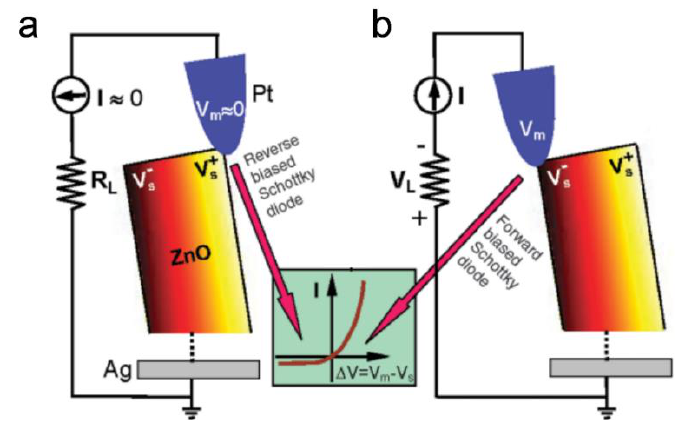
Figure 3. Working principle of a piezoelectric nanogenerator (PENG): contacts between the atomic force microscope (AFM) tip and the semiconductor ZnO nanowire at two reversed local contact potentials (positive and negative), showing reverse and forward biased Schottky rectifying behavior, respectively. This oppositely biased Schottky barrier across the nanowire preserves the piezoelectric charges and later produces the discharge output. The inset shows a typical current–voltage (I–V) relation characteristic of a metal-semiconductor (n-type) Schottky barrier. The process in ( a ) is to separate and maintain the charges as well as build up the potential. The process in ( b ) is to discharge the potential and generates electric current. Reproduced with permission [1]. Copyright 2006, American Association for the Advancement of Science.